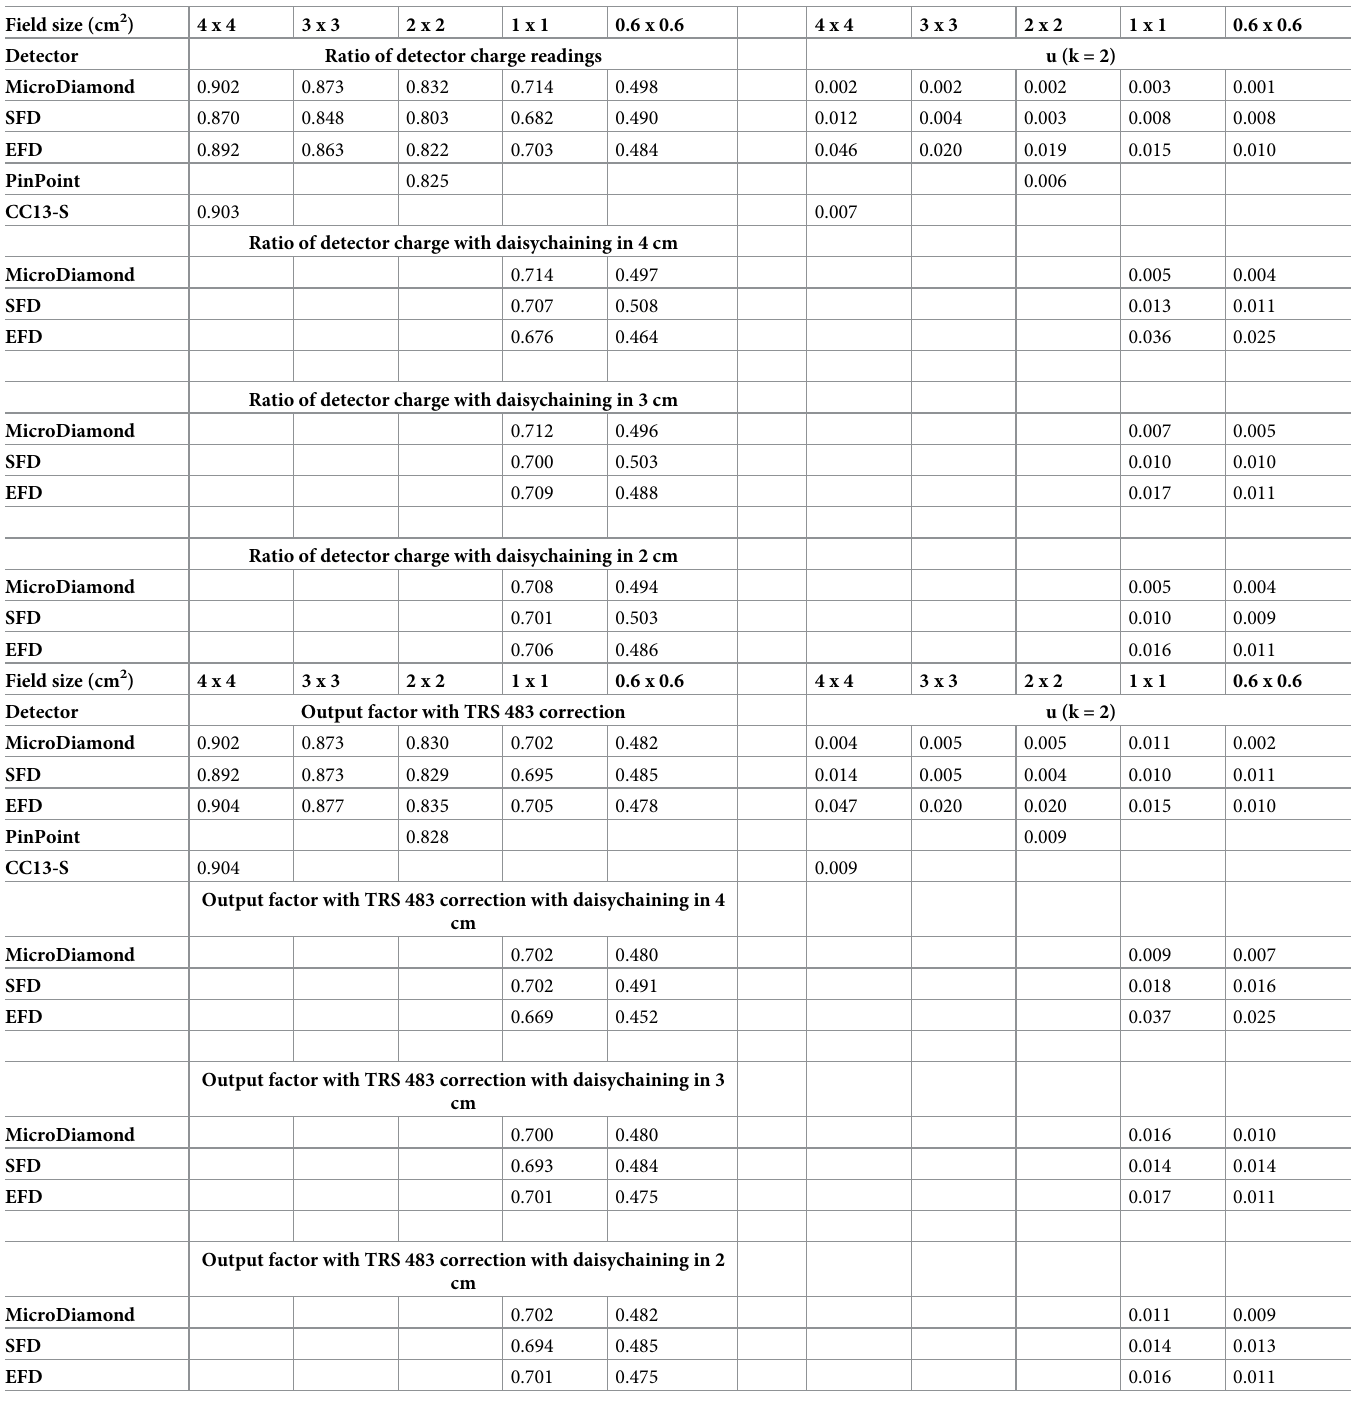
Table 5. Ratio of detector readings for different detectors depending on the field size for 6 FFF MV beams (top of the table) and output factors with TRS 483 correc- tion (bottom of the